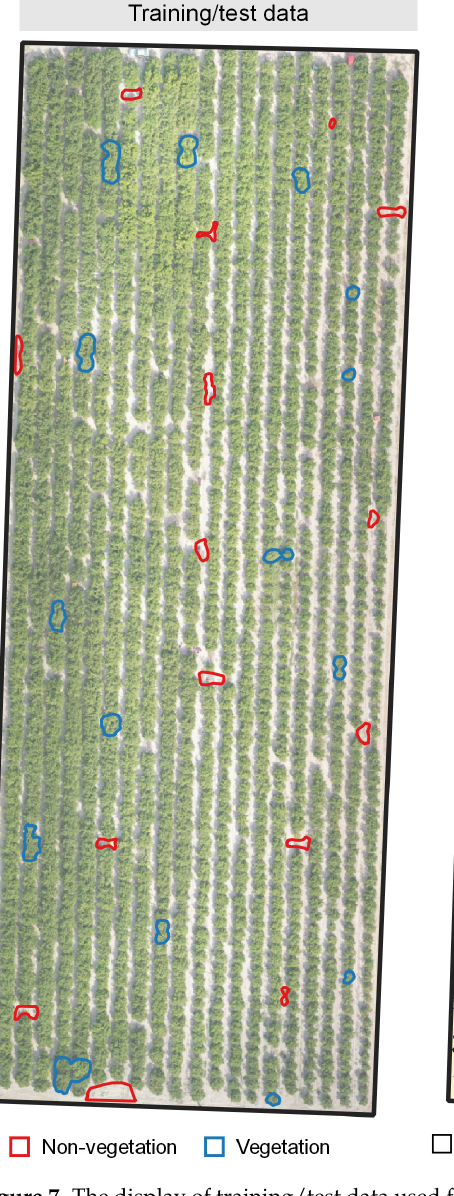
Figure 7. The display of training/test data used for supervised classification and the vegetation mask calculated from the classification. Table 3. The absolute and relative area of FAO suitability classes for tangerine